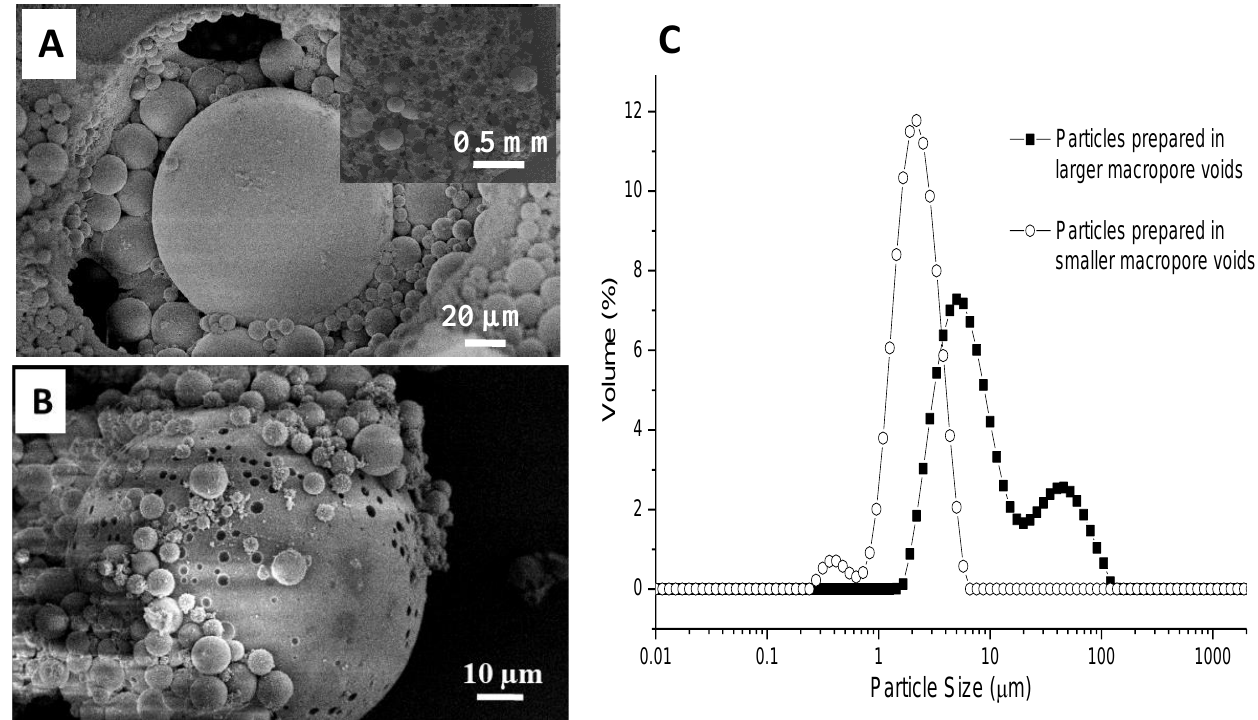
Figure 5. ( A ) SEM image of the composite monolith prepared with MPTMS as a precursor and the PAM monolith with large macropore voids prepared from 75 v / v % internal phase emulsion formed by stirring at 500 rpm; ( B ) SEM image of silica microspheres generated after calcining the composite in air at 550 ◦ C; ( C ) particle size distribution of silica microspheres formed after calcination. These silica microspheres were suspended in aqueous medium and measured by